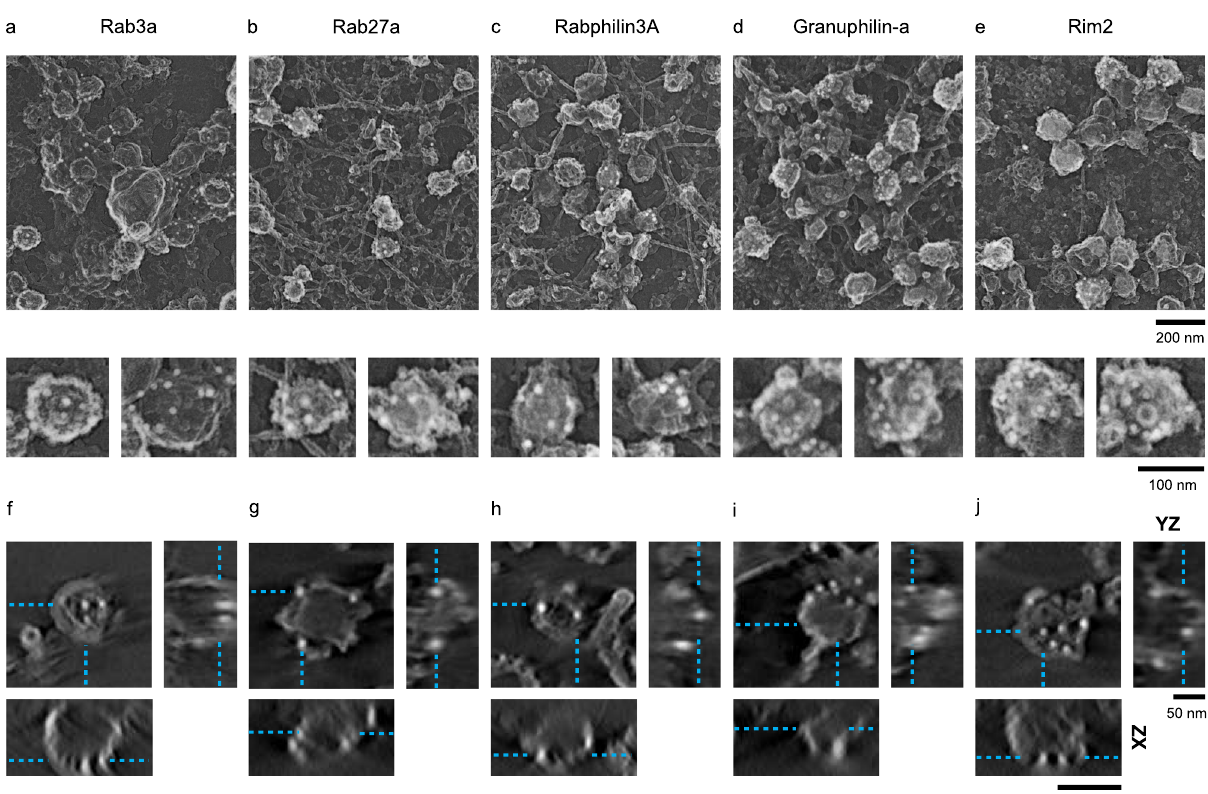
Fig. 4 Gold nanoprobe labeling of DCV proteins imaged with 2D and 3D PREM. 2D PREM images of PC12 cells transfected with His-tagged a Rab3a, b Rab27a, c Rabphilin3a, d Granuphilin-a, and e Rim2. The upper panel shows a representative crop from a larger PREM image of a cell (Supplementary Fig. 12) and the lower panel shows enlarged examples of individual DCV structures labeled with Ni-NTA-Au. Scale bars are 200 and 100 nm, respectively. Tomogram slice ( XY view, scale bar = 100 nm) of an individual DCV structure labeled with Ni-NTA-Au for f Rab3a, g Rab27a, h Rabphilin3a, i Granuphilin- a, and j Rim2, and the XZ (scale bar = 100 nm) and YZ (scale bar = 50 nm) views for the z slice denoted by cyan dashed lines. Two independent imaging experiments were performed for 2D- and